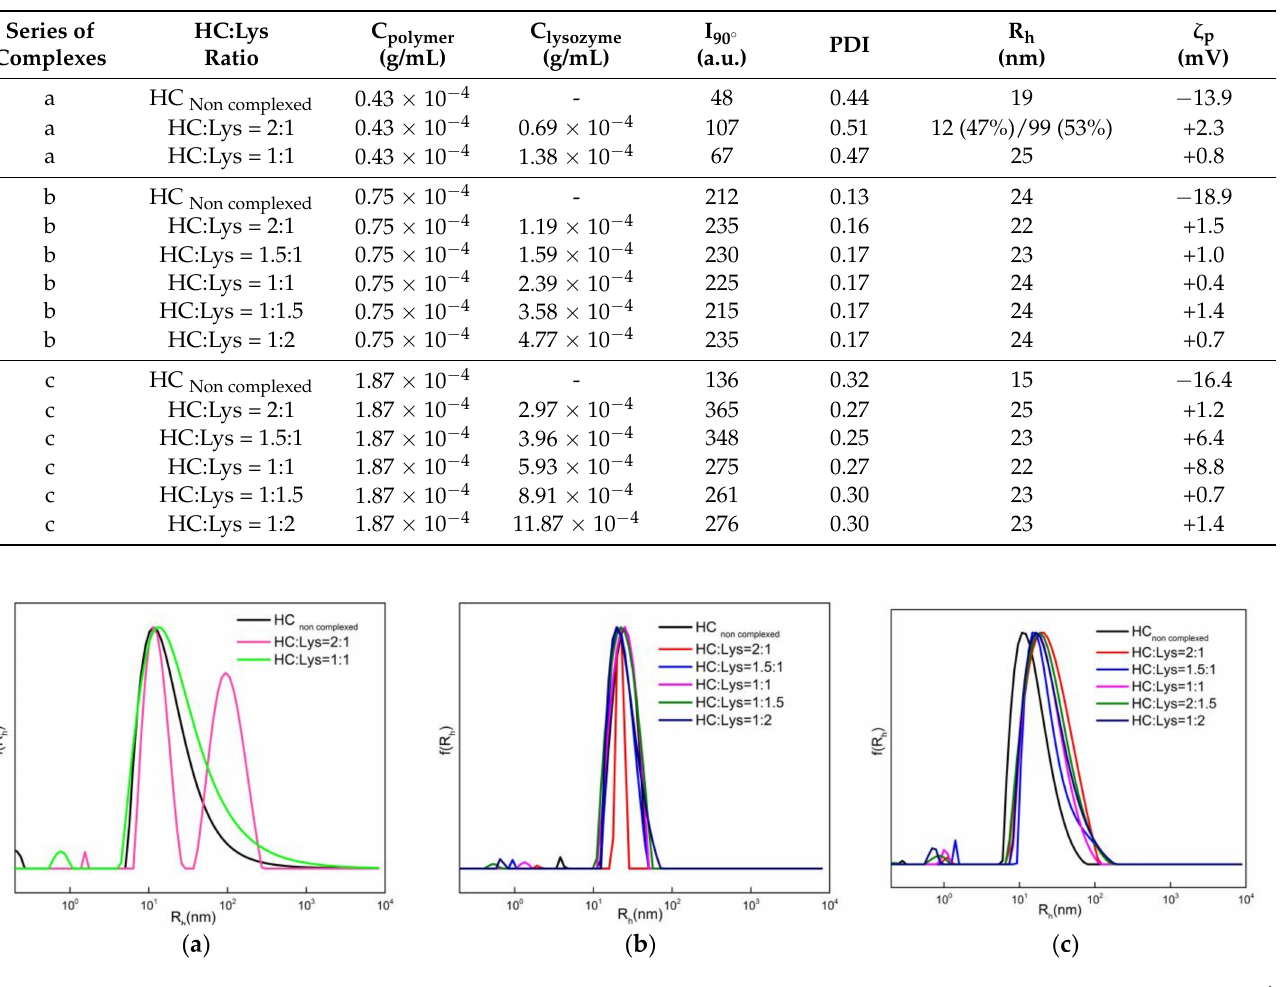
Figure 6. Size distributions of the HC–Lys complexes at HC concentrations of ( a ) 0.43 × 10 − 4 , ( b ) 0.75 × 10 − 4 and ( c ) 1.87 × 10 − 4